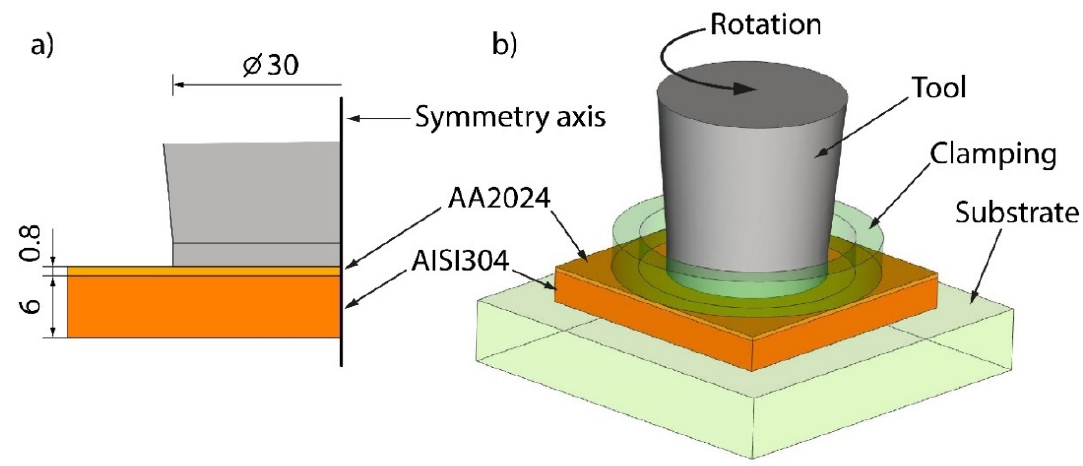
Figure 2. P-FSSW lap configuration: cross-sectional dimensions ( a ), CAD model ( b ).